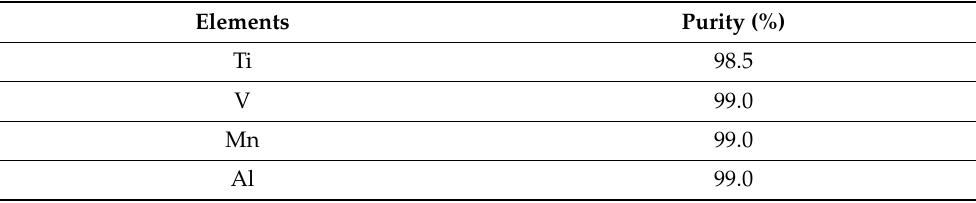
Table 1. The purity level of different powders by using XRF